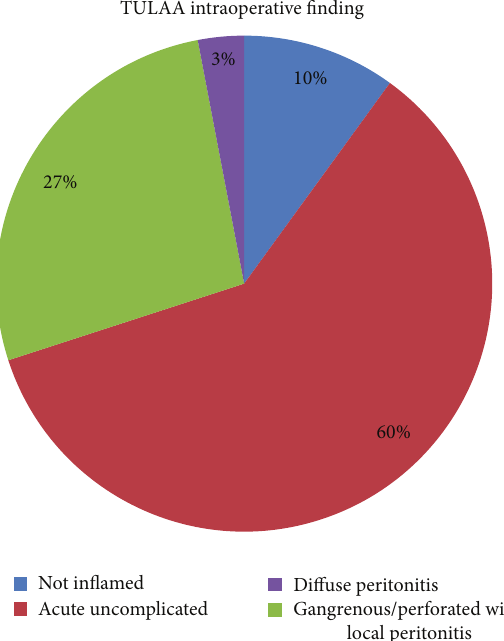
Figure 2: TULAA intraoperative finding. Macroscopic staging of the appendiceal